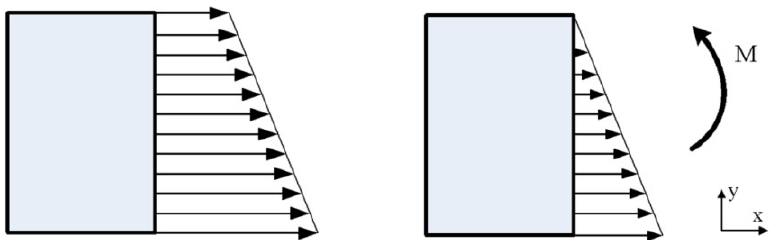
Figure 11. The distribution of axial normal stress and bending stress at different distances from inner curved surface.